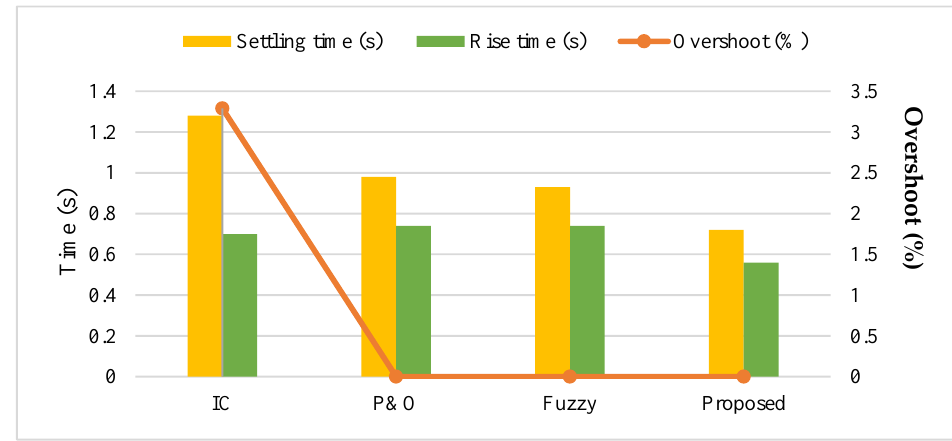
Figure 21. Comparative analysis based error and time.